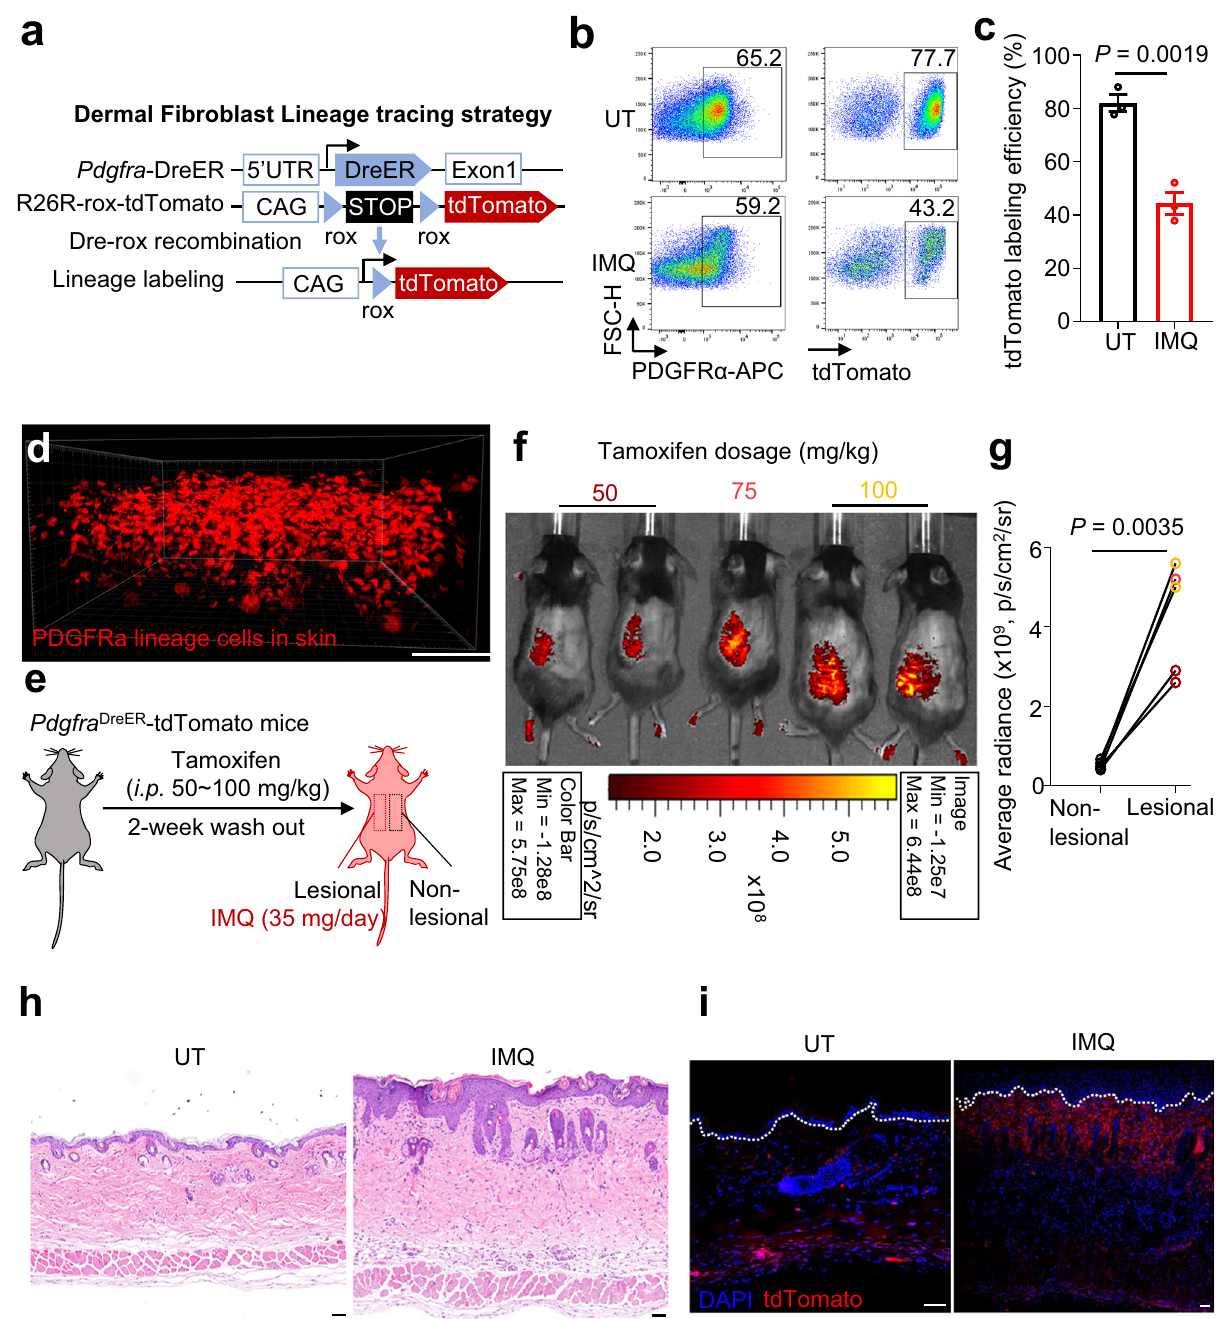
Fig. 1 | Lineage-tracing-based imaging shows altered fi broblast quantity and distribution in in fl amed mouse skin. a Fibroblast lineage-tracing strategy of Pdgfra DreER -tdTomato mice. Flow cytometric analysis ( b ) and quanti fi cation ( c ) of tdTomato labeling ef fi ciency in dermal PDGFRa + fi broblasts of untreated (UT) and imiquimod (IMQ)-induced mouse skin ( n =3). d Representative whole-mount images of untreated Pdgfra DreER -tdTomato mouse skin. Scale bar, 100 μ m . e Sche- matic diagram of IMQ-induced psoriasis mouse model in self-control Pdgfra DreER - tdTomato mice with different tamoxifen dosages. Luminescence imaging ( f ) and